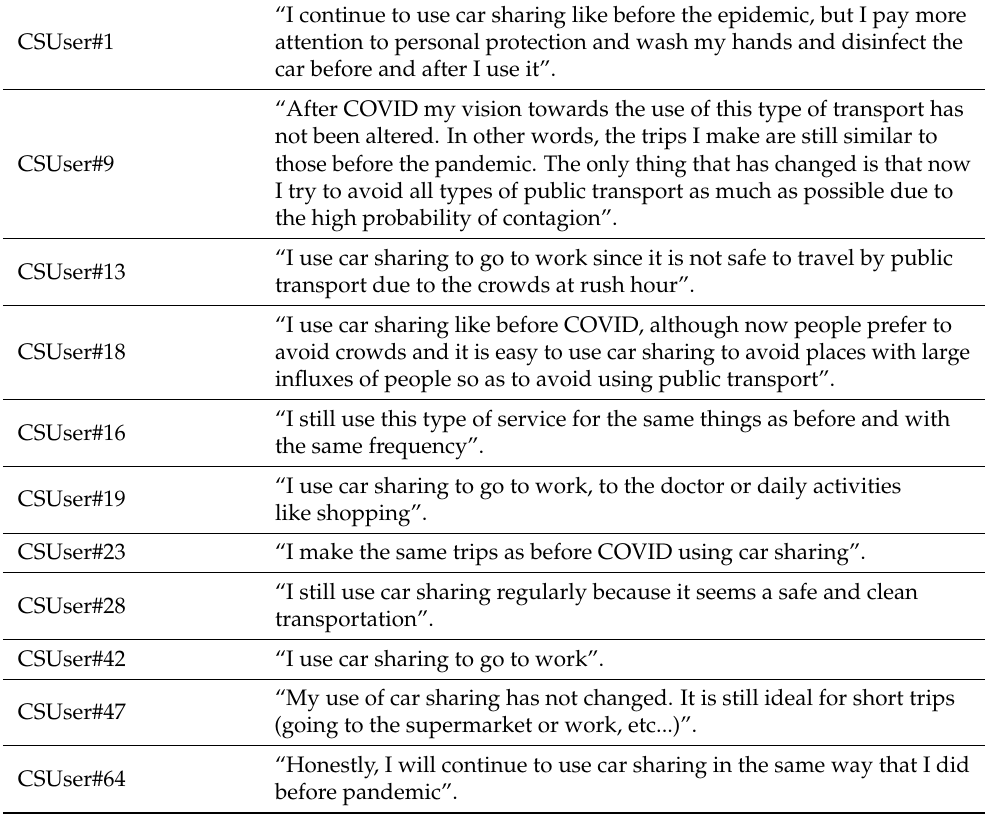
Table 2. Car sharing usage during the